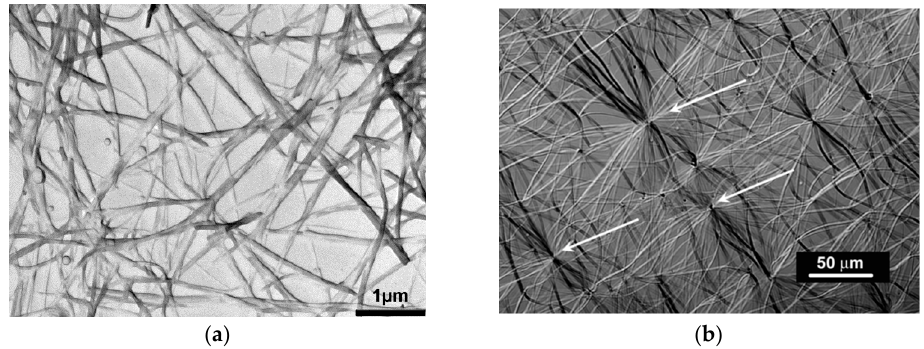
Figure 1. ( a ) TEM micrograph of an OPVR/ trans -decahydronaphthalene, which shows a typical randomly-dispersed network ( b ) optical micrograph of an OPVOH/ trans -decahydronaphthalene organogel displaying a hub-like network where fibrils radiate from and connect to nodes (arrows). Chemical structures in Appendix Figure A1 [13,14].